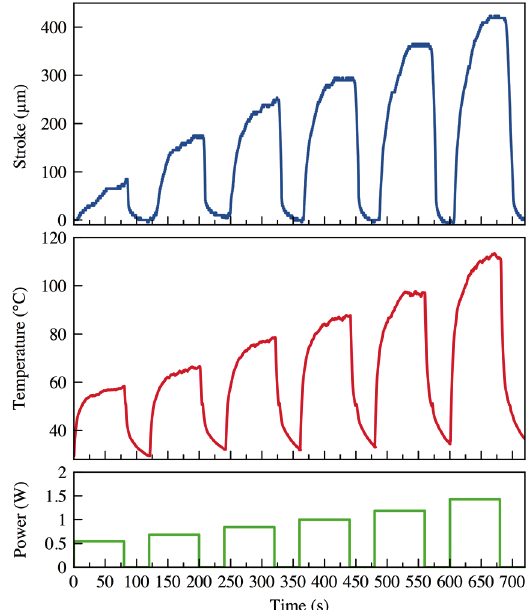
Figure 11. Time-resolved signals of stroke, temperature at the hot side T 2 , and heating power. The temperature gradient is generated by Joule